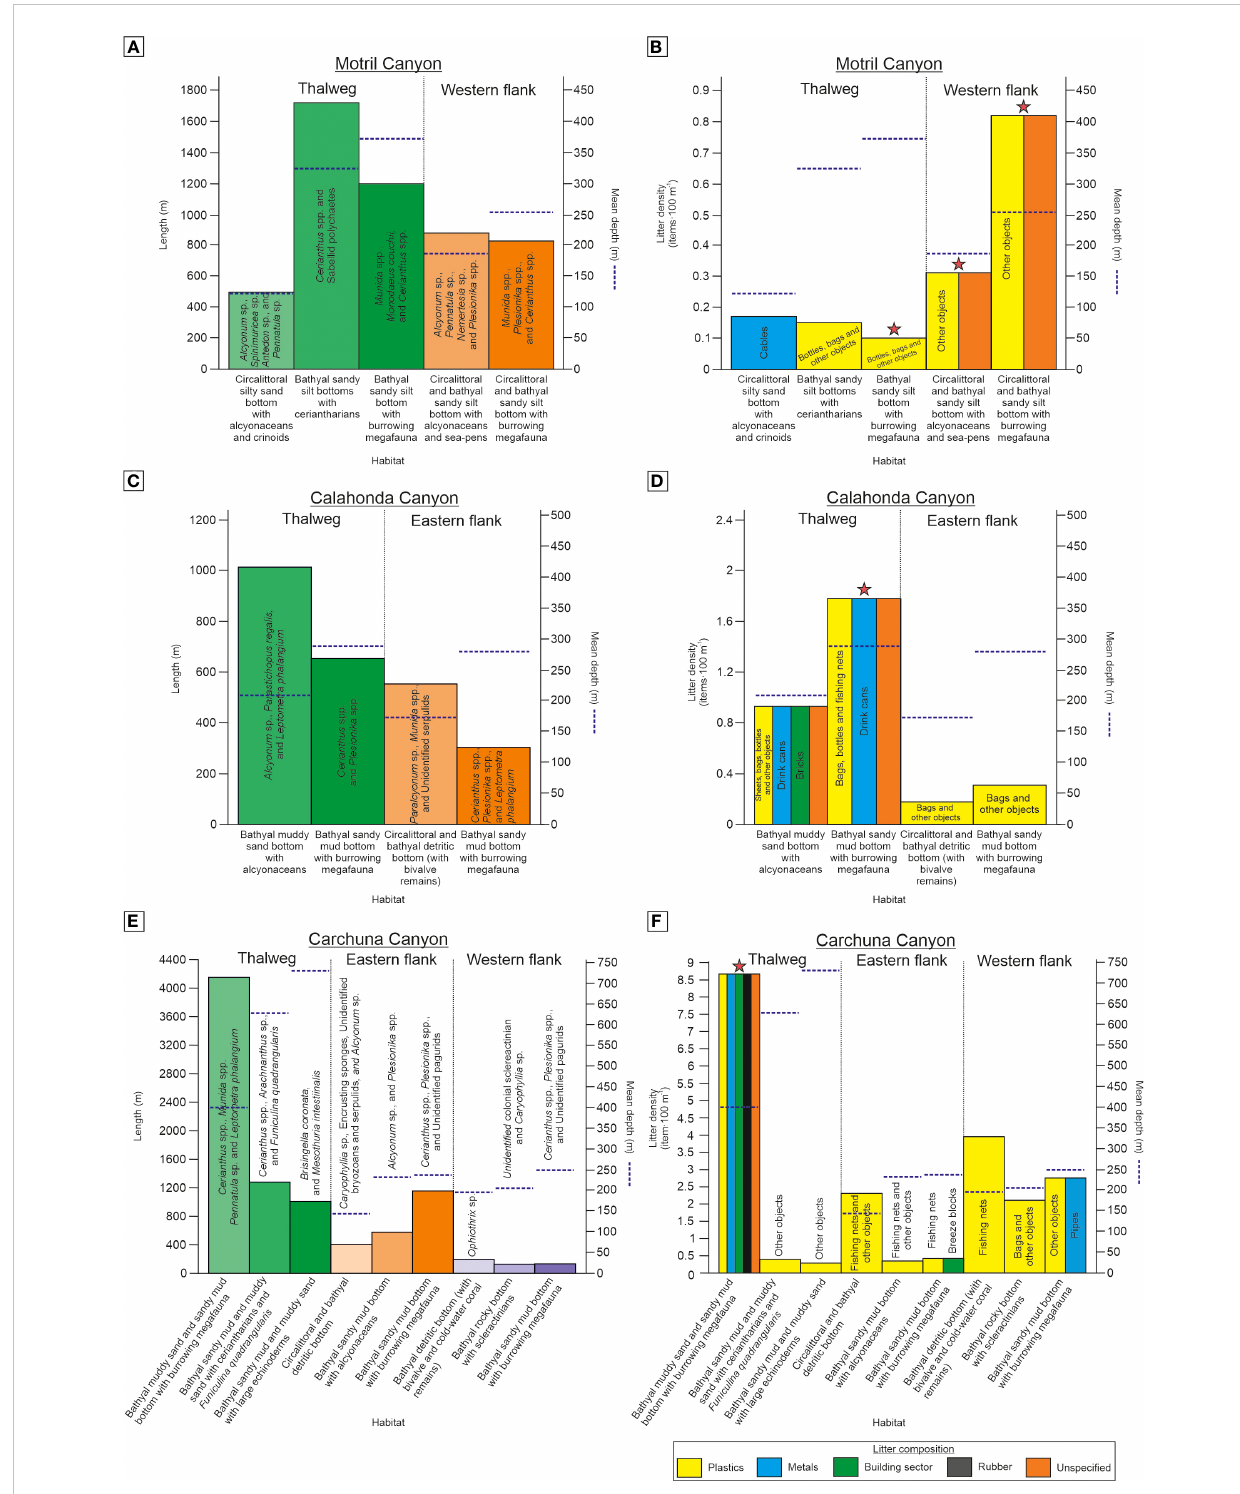
FIGURE 8 Types and length (in ROV underwater image transects) of habitats detected along the Motril (A) , Calahonda (C) , and Carchuna (E) canyons, with annotations of the dominant taxa and mean water depth (blue dotted line) of each habitat. Litter density and types of litter and other anthropic activity indicators along the Motril (B) , Calahonda (D) , and Carchuna (F) canyons is also shown. Stars indicate the presence of sea fl oor marks from bottom trawling in a particular